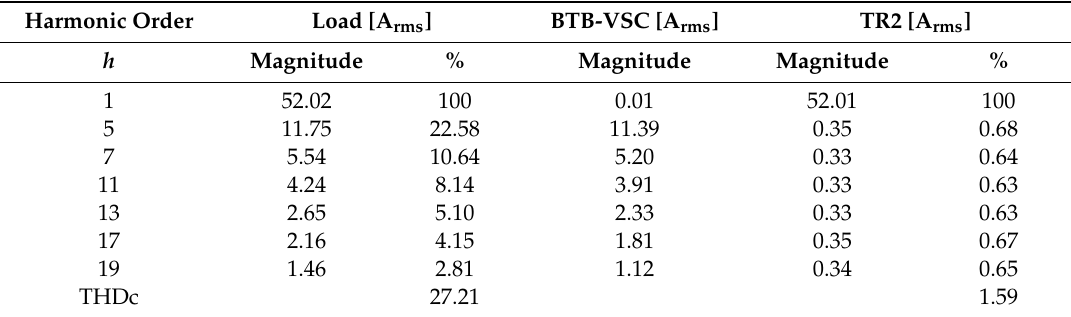
Table 4. Current harmonic components: simulation results of the considered case.